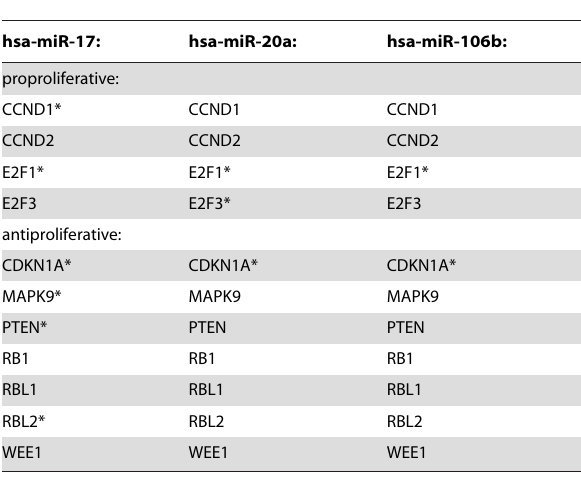
Table 1. Cell-cycle related proteins predicted as targets for miR-17, miR-20a, and miR-106b and chosen for experimental target gene